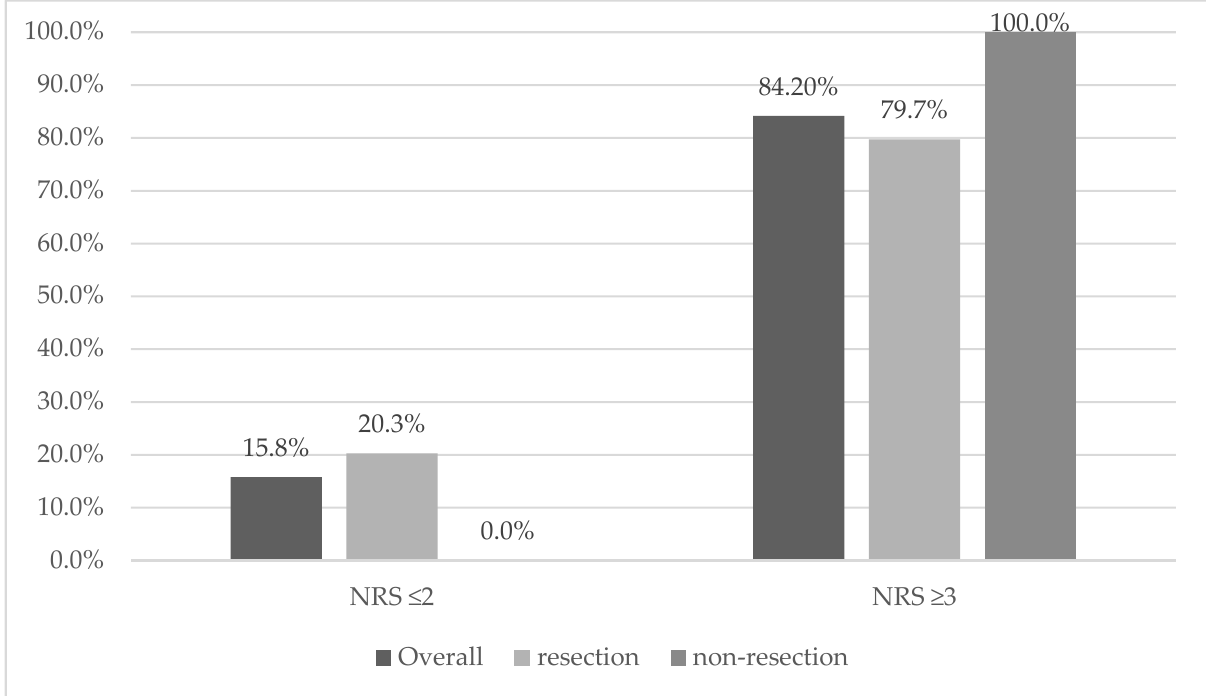
Figure 1. Distribution of the risk of malnutrition based on NRS 2002 compared with overall, resection and non-resection tumor group: NRS ≤ 2: no risk of malnutrition, NRS ≥ 3: risk of malnutrition.